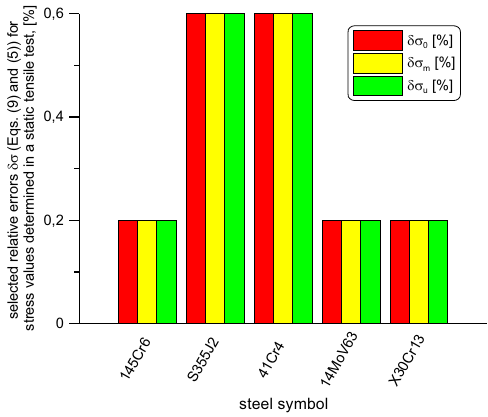
Figure 7: Comparison of the absolute errors Δ σ including the com - pensation for individual errors of component quantities, for selected stress values using equation ( 10 ) .